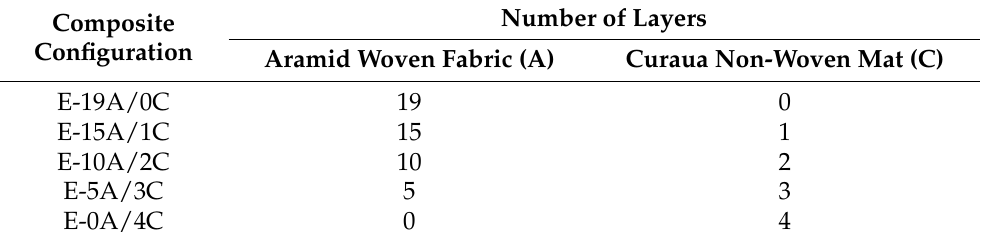
Table 2. Composite configurations based on the number of reinforcing layers.